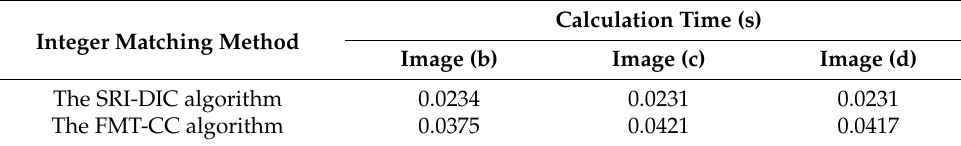
Table 2. Experimental results of comparing the efficiency of the proposed algorithm with the FMT- CC